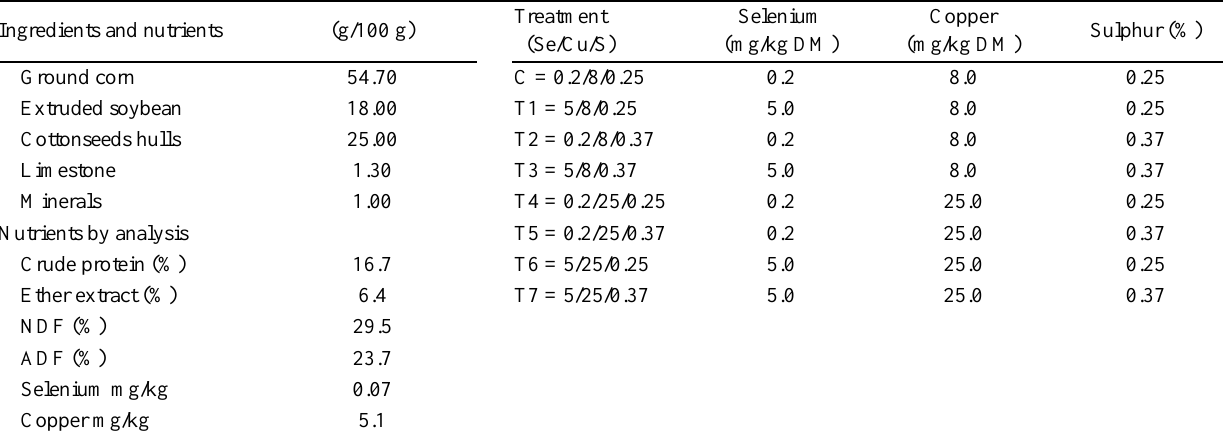
Table 1. Composition of the basal diet (dry matter ) and treatment description Ingredients and